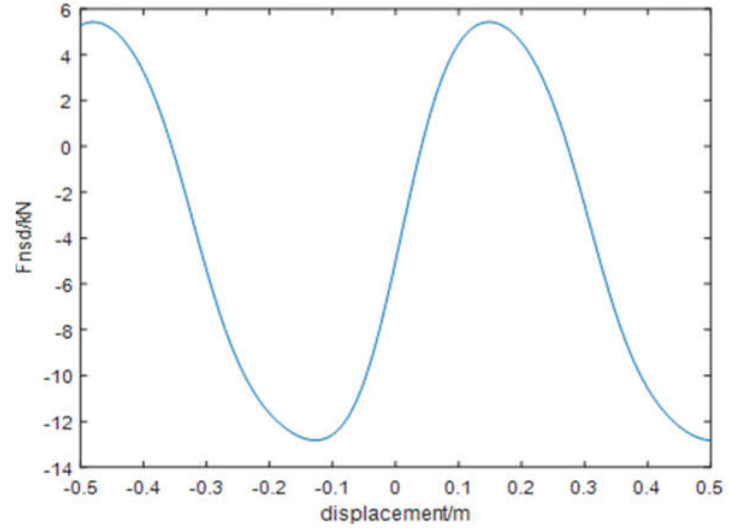
Figure 4. Mechanical model of negative−stiffness device. The relationship between negative stiffness, K NSD , and displacement, x , can be drawn from Equation (7), as shown in Figure 5.